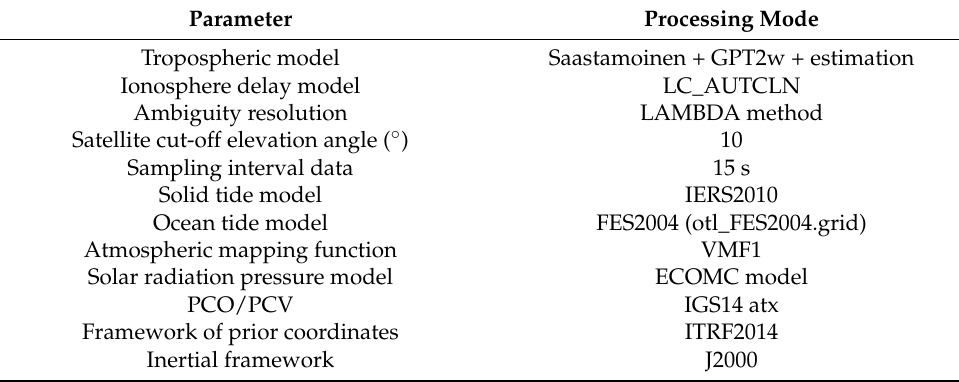
Table 1. The main parameters used in the GAMIT calculation